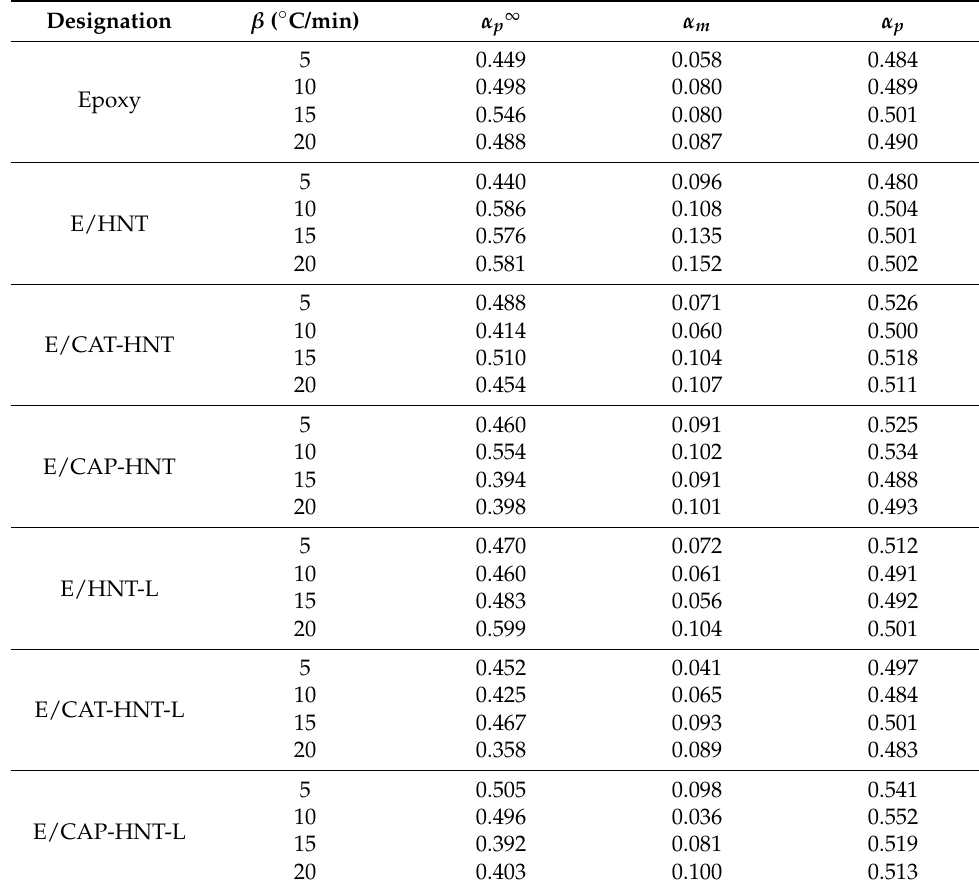
Table 2. The values of α p , α m , and α p ∞ obtained from DSC analysis based on Malek model at various heating rates ( β